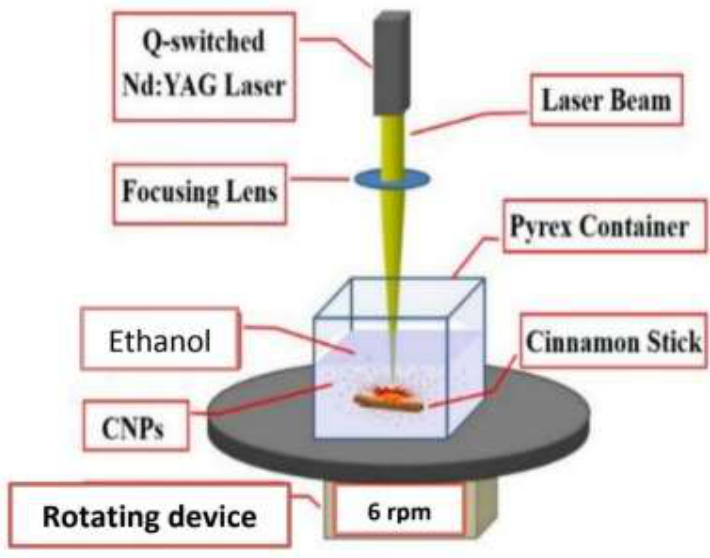
Fig 1: Schematic diagram of the "pulsed laser ablation in Liquid system" (PLAL). Results and